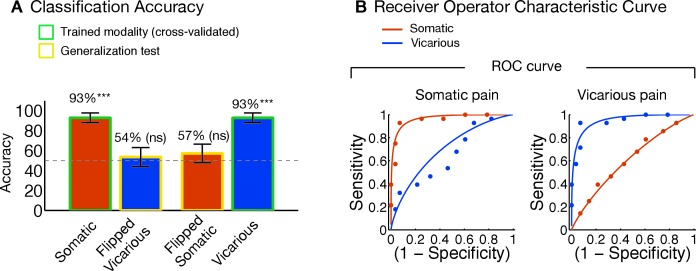
Upper limb versus lower limb analyses with left-right flipped testing data.(A) Accuracy statistics for upper limb versus lower limb weight maps for somatic and vicarious pain; (B) Receiver Operating Characteristic (ROC) curves for two-choice forced alternative tests for somatic and vicarious pain and high and low stimulations for each pain type.